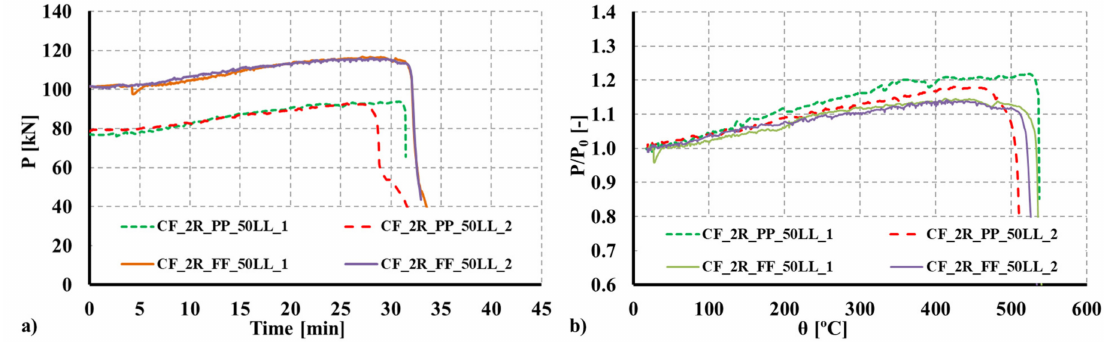
Figure 9. ( a ) Evolution of axial forces due to restraint to thermal elongation for the composite 2R section. ( b ) Evolution of the P/P 0 ratio for the composite 2R section.